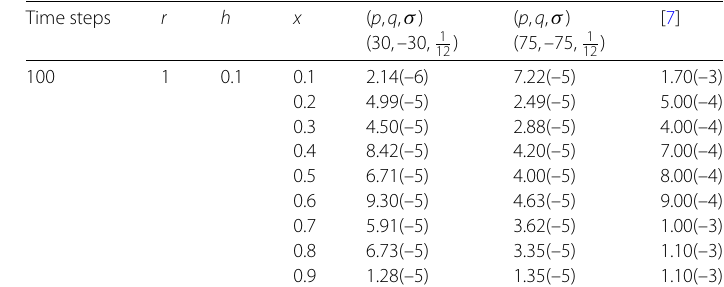
Table 2 Comparison of L ∞ error with [7] for Example 1